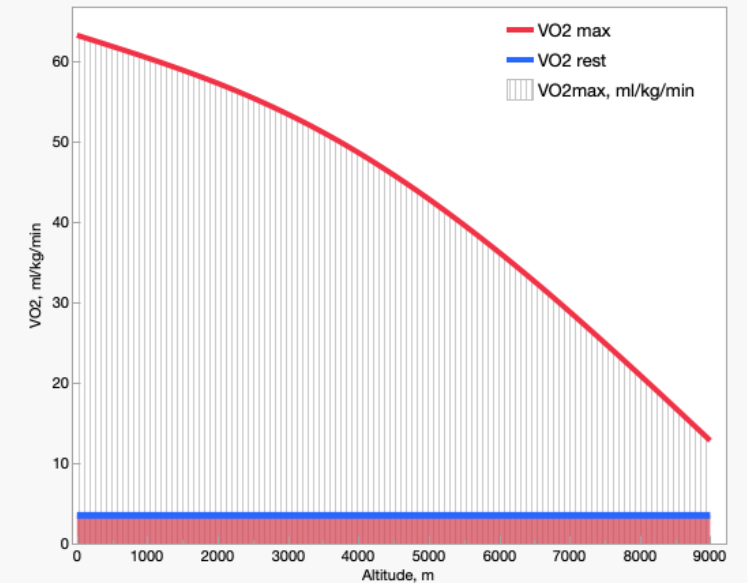
Figure 2. Behavior of maximal (red) and resting (blue) VO 2 at altitude. Data redrawn from [12], which reports the average of 146 studies performed at various real and simulated altitudes in the 0–9000 m range regardless of the training degree. The dashed area represents the O 2 available to perform